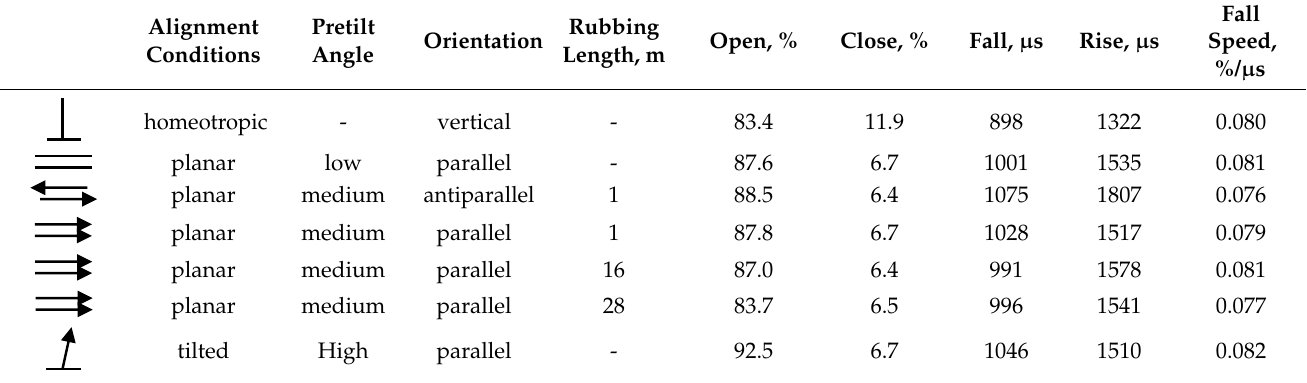
Table 1. E-O test at 525 nm results depending on rubbing strength, L(m) and surface condition.